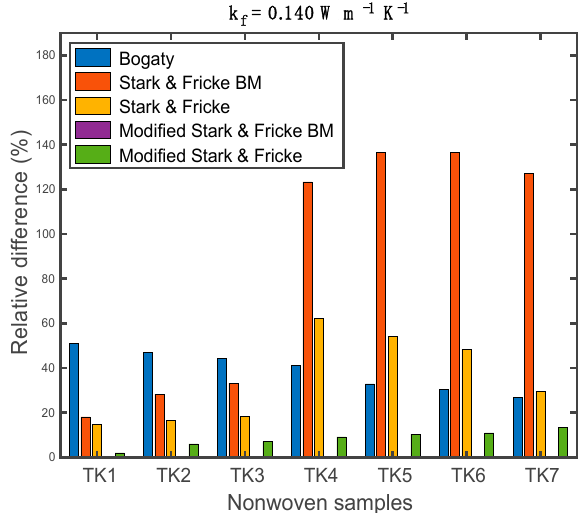
Figure 14. Predicted and measured thermal conductivities of the nonwoven samples.